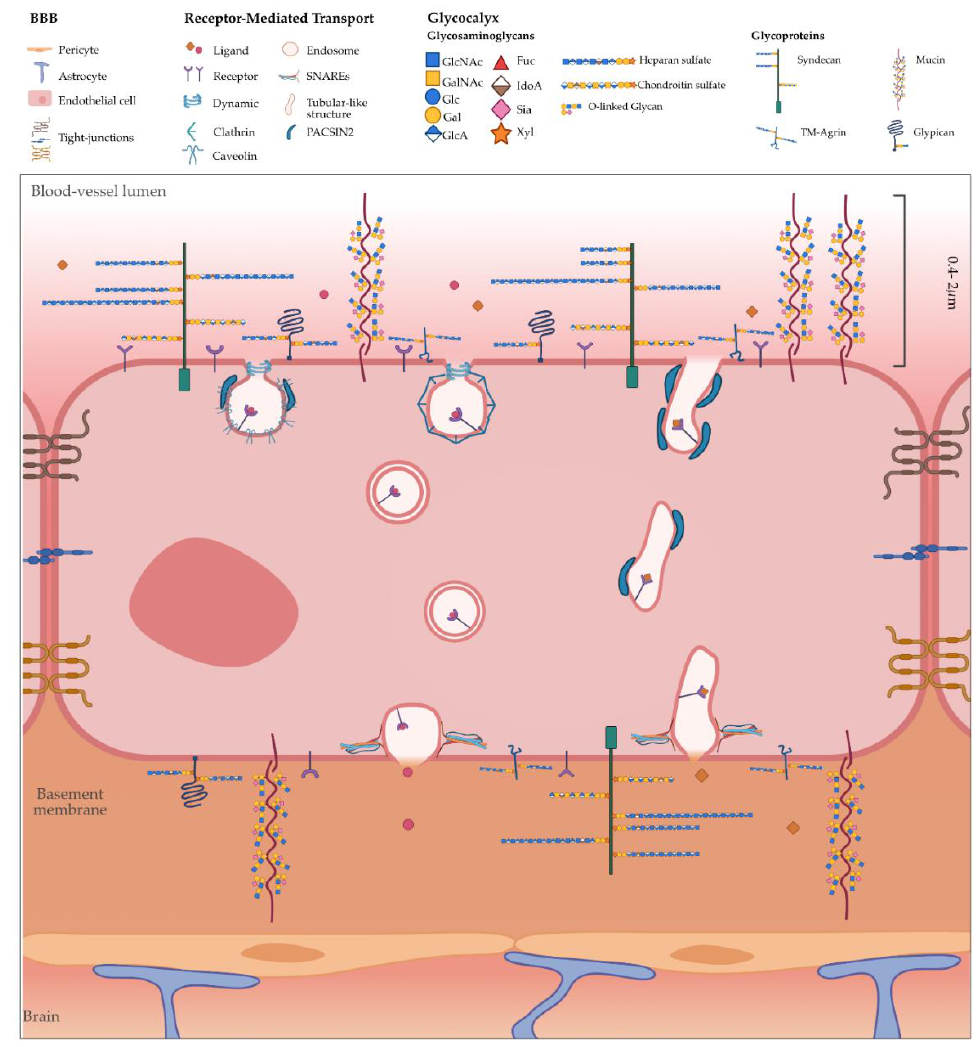
Figure 1. Schematic representation of the glycocalyx (GC) in the blood – brain barrier (BBB) and the mechanisms of transcytosis. The BBB consists of vascular cells (endothelial cells, pericytes and smooth muscle cells), glia (astrocytes, microglia and oligodendrocytes) and neurons. The non-fenestrated brain endothelium is characterised by the presence of tight junctions. Moreover, a layer of the GC covers the luminal/apical surface of the endothelium (0.2 – 2 µm). The GC brush is highly dynamic with a unique composition of glycoproteins and glycans. Within the glycoproteins, proteoglycans, such as syndecans, glypicans and TM-agrin, contain GAGs (heparan and chondroitin sulphate chains) anchored to the core protein. These proteins may affect the binding of ligands to their receptors and endocytosis. Once the ligand binds to the receptor, the cargo undergoes endocytosis via caveolae- or clathrin-dependent or clathrin-independent mechanisms, with intracellular trafficking mediated by endosomal/lysosomal or a direct route mediated by tubular carriers, and eventually exocytosis.